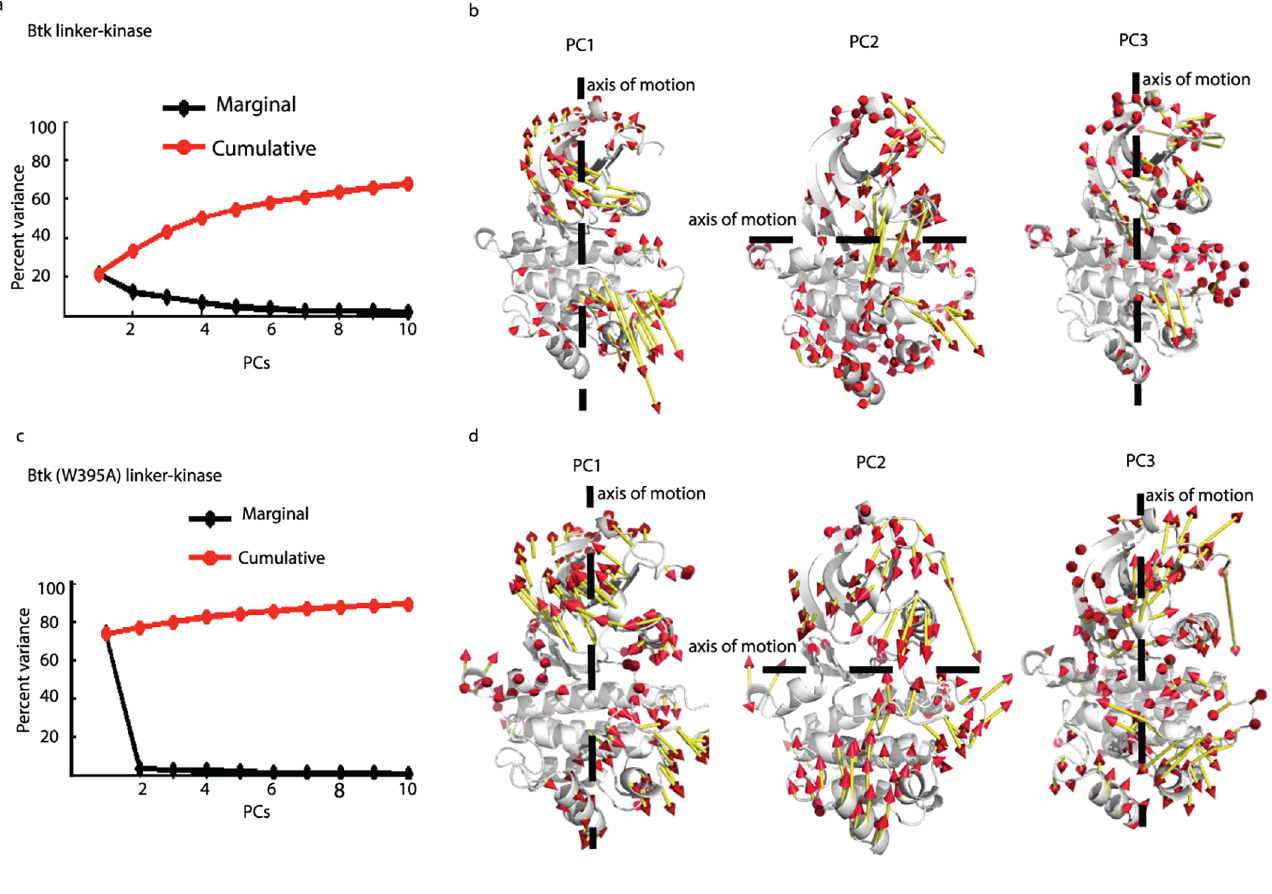
Fig 4. Principal Component Analysis. (a,c) Percent variance captured by the first 10 PCs in Btk linker-kinase (a) and Btk (W395A) linker-kinase (c) domains. The red line is the cumulative variance captured by the PCs and the black line is the percentage of the variance captured by each individual PC. (b, d) Direction of motions in PC1, PC2 and PC3 for Btk linker-kinase (b) and Btk (W395A) linker-kinase (d) domain. Dotted lines show the axis of motion, the length of the vectors show the relative magnitudes and the arrowheads indicate the direction of